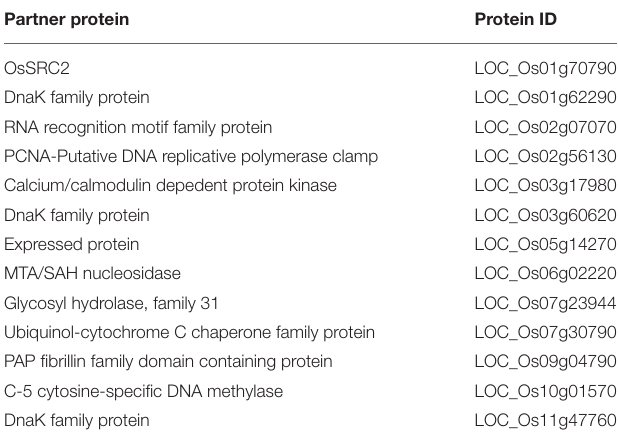
TABLE 1 | Partner proteins of NHO1 selected in the process of yeast two-hybrid (Y2H) screening. Partner